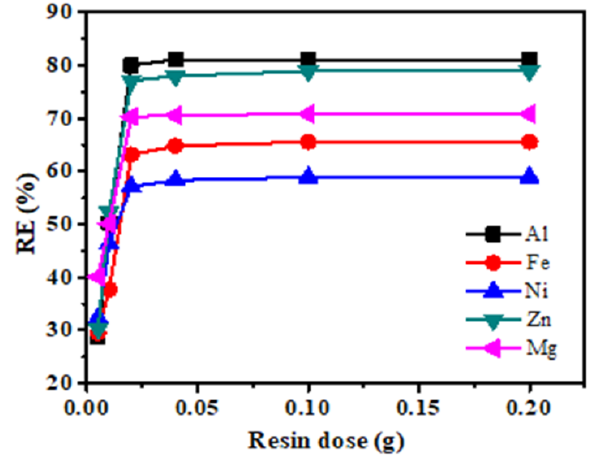
Figure 2. E ff ect of resin dosage on the ion exchange of Al(III), Fe(II), Zn(II), Mg(II) and Ni(II) using the AmberliteIR-120 (temperature: 318 K; stirring speed: 150 rpm; contact time, 15 min).